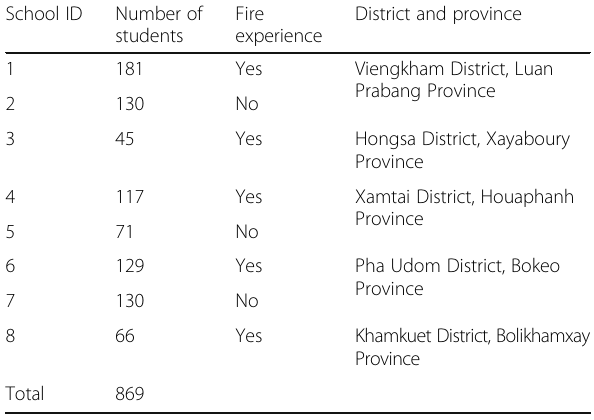
Table 1 Student number, fire experience, and location of study